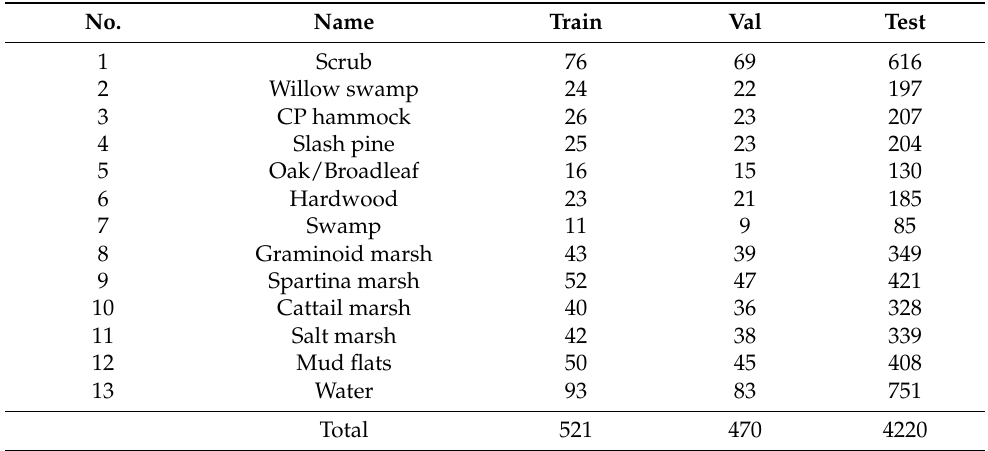
Table 2. The number of training, validation, and testing samples for Kennedy Space Center dataset. No.